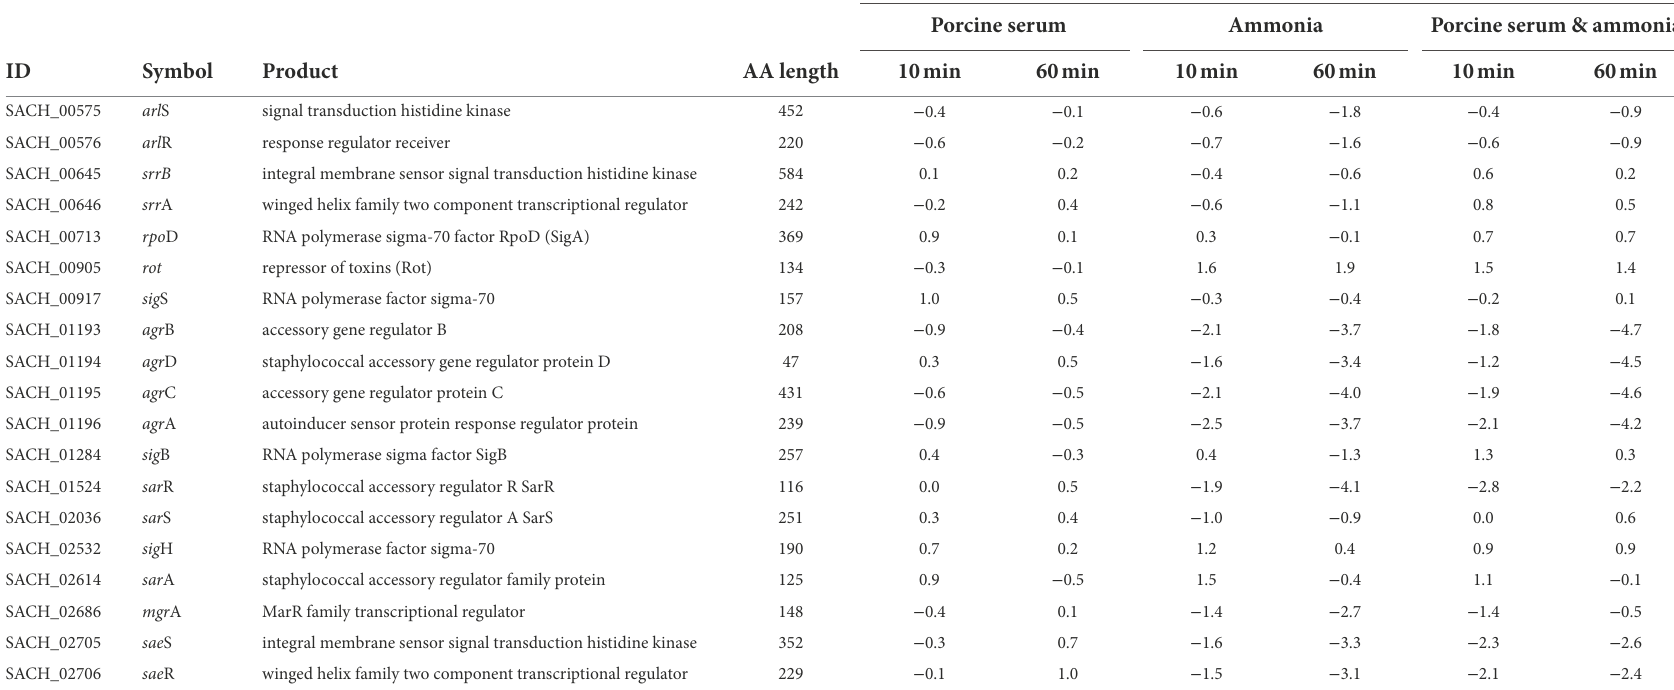
Gene transcription (log2FC) compared to unchallenged control samples Porcine serum Porcine serum &